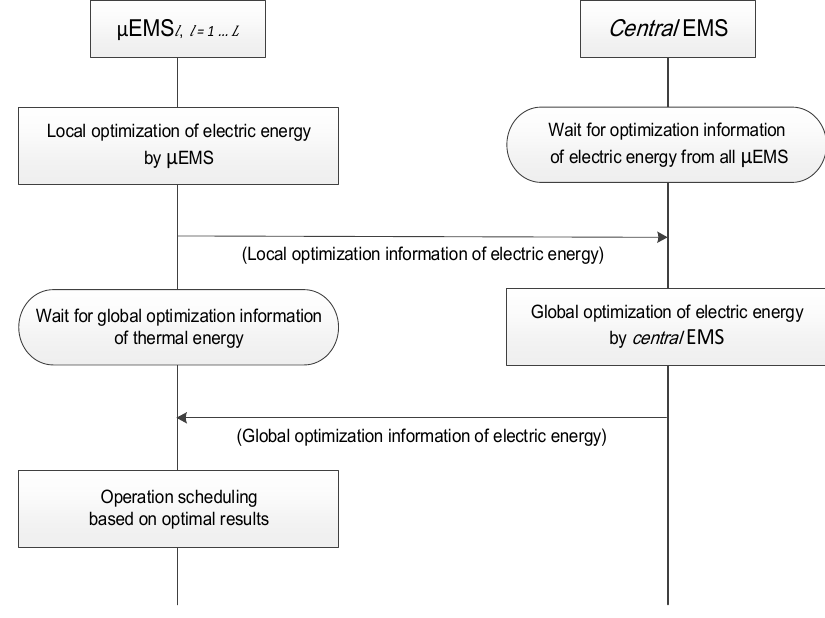
Figure 2. Sequential operations of energy management in a cooperative